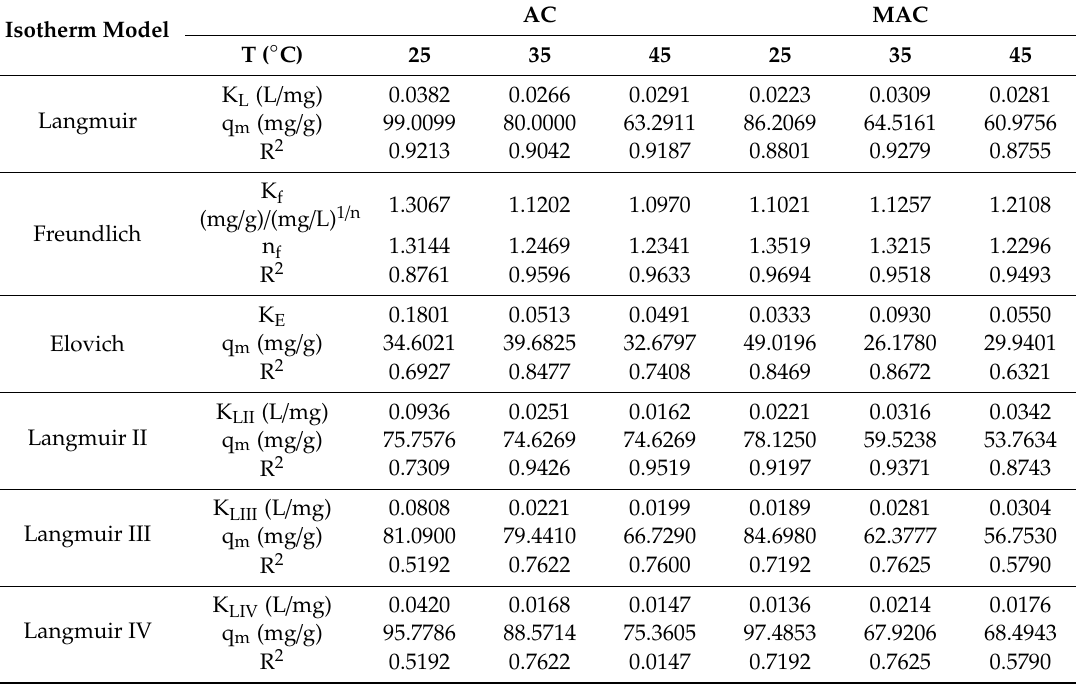
Table 4. Parameters of the di ff erent isothermal models for AC and MAC. Isotherm